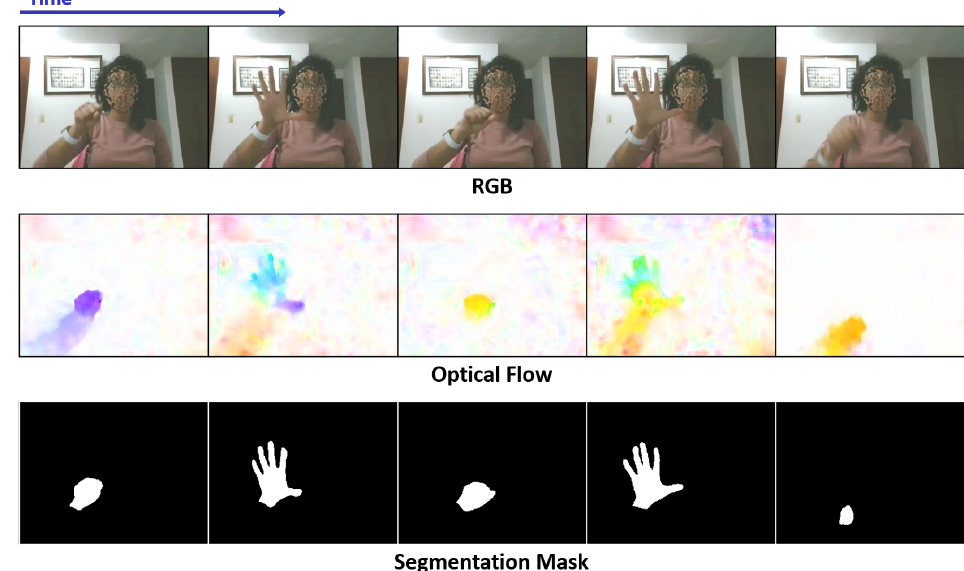
Figure 1. Example of the three different modalities analyzed in this paper. Note that segmen- tation masks and optical flow images can be performed in real-time using FASSD-Net [16] and SpyNet [19],